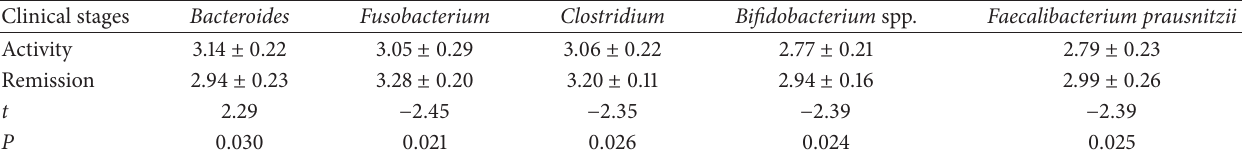
Table 5: The quantitative results of bacteria in feces in different clinical stages ( 𝑥 lg 𝑥 ± 𝑠 lg 𝑥 ). Clinical stages